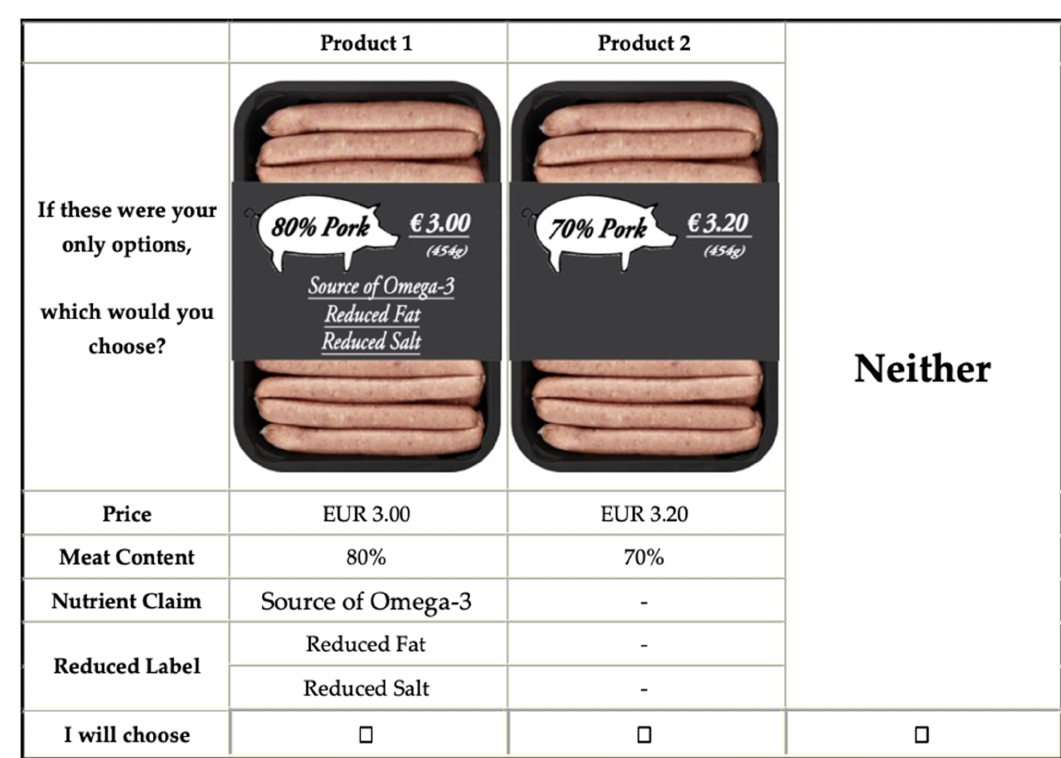
Figure A7. Choice set 7 in the questionnaire